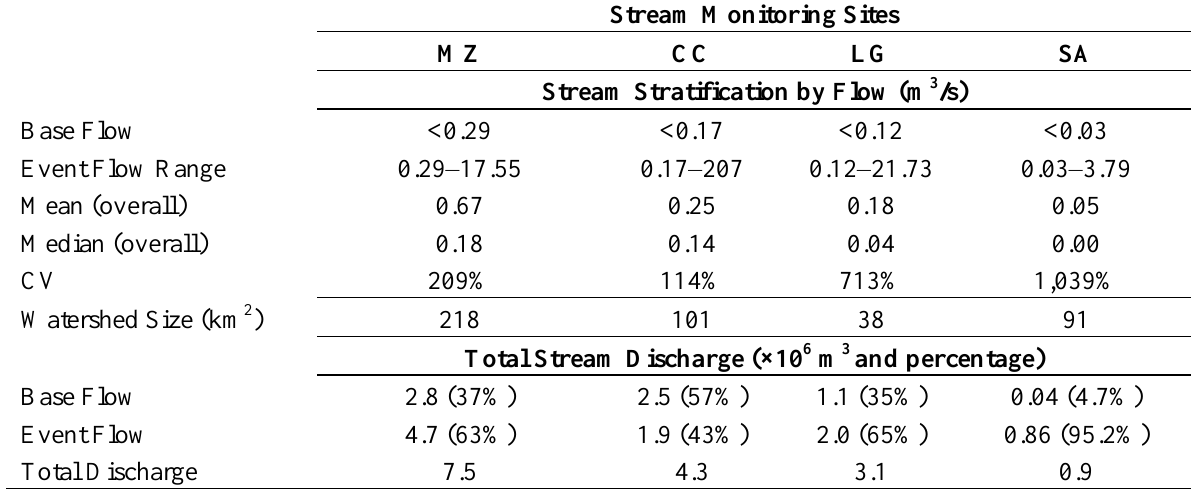
Table 1. Flow stratification results for Montezuma (MZ), Cow Creek (CC), Lower Gallinas (LG), and Spring Arroyo (SA) for 2003 and 2004. (Stream Stratification based on Daily Mean